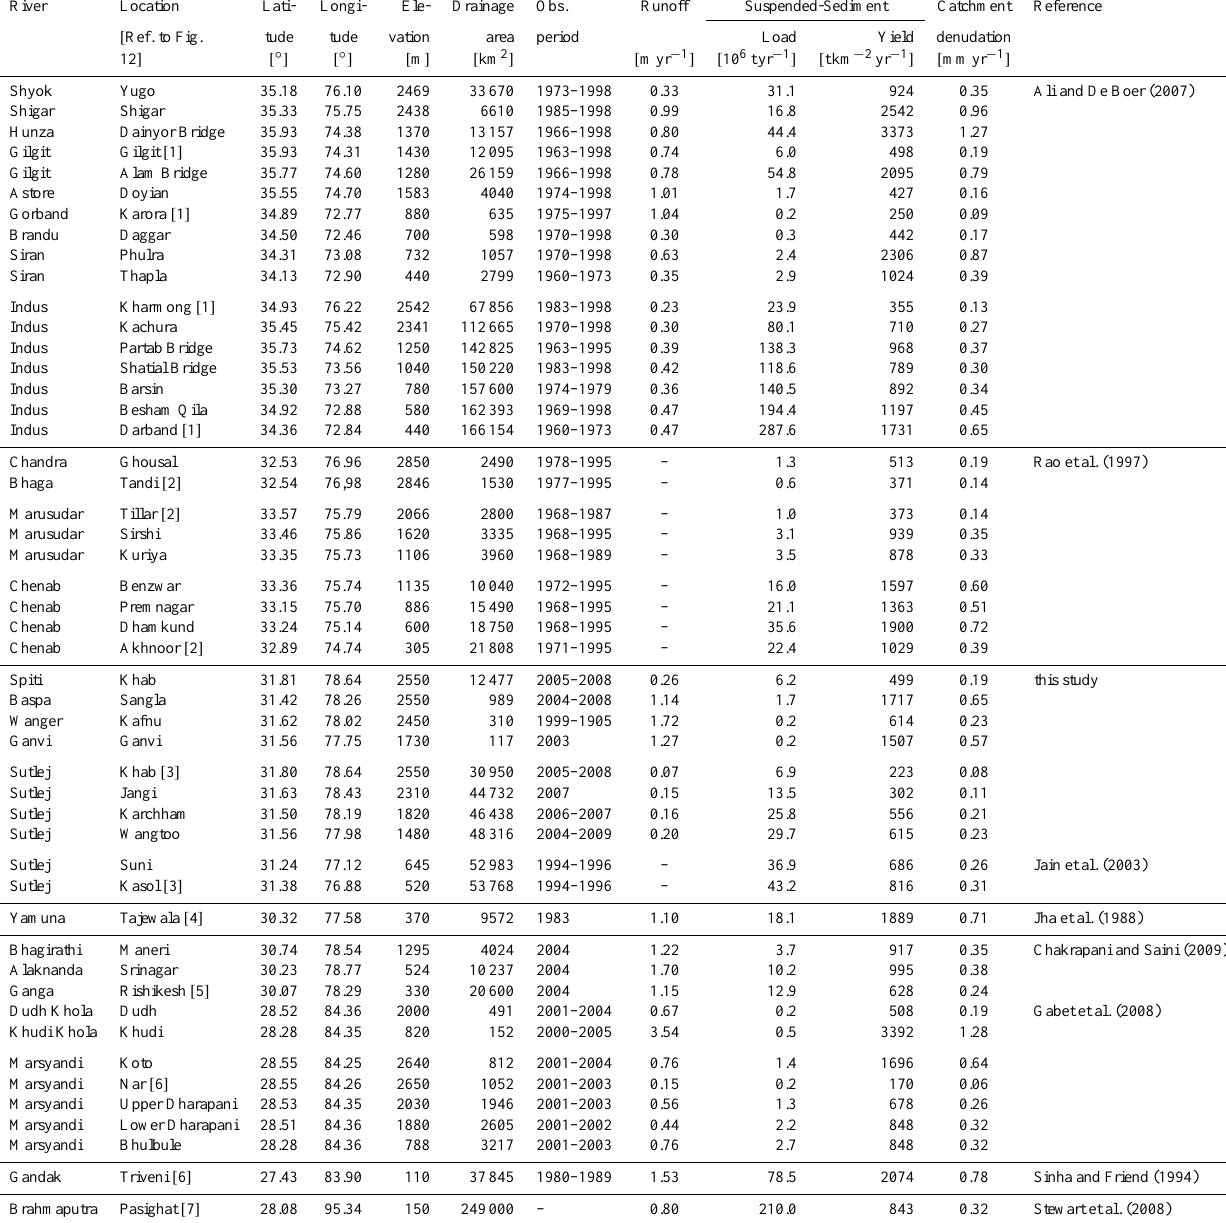
Table 5. Compilation of suspended sediment flux data for some Himalayan rivers. We first list tributaries followed by their corresponding main stems in downstream direction ranging from west to east. The catchment denudation rate is based on a bulk rock density of 2.65gcm − 3 and accounts only for the suspended sediment flux. Note that data from this study reflect sediment flux during the summer half-year only.